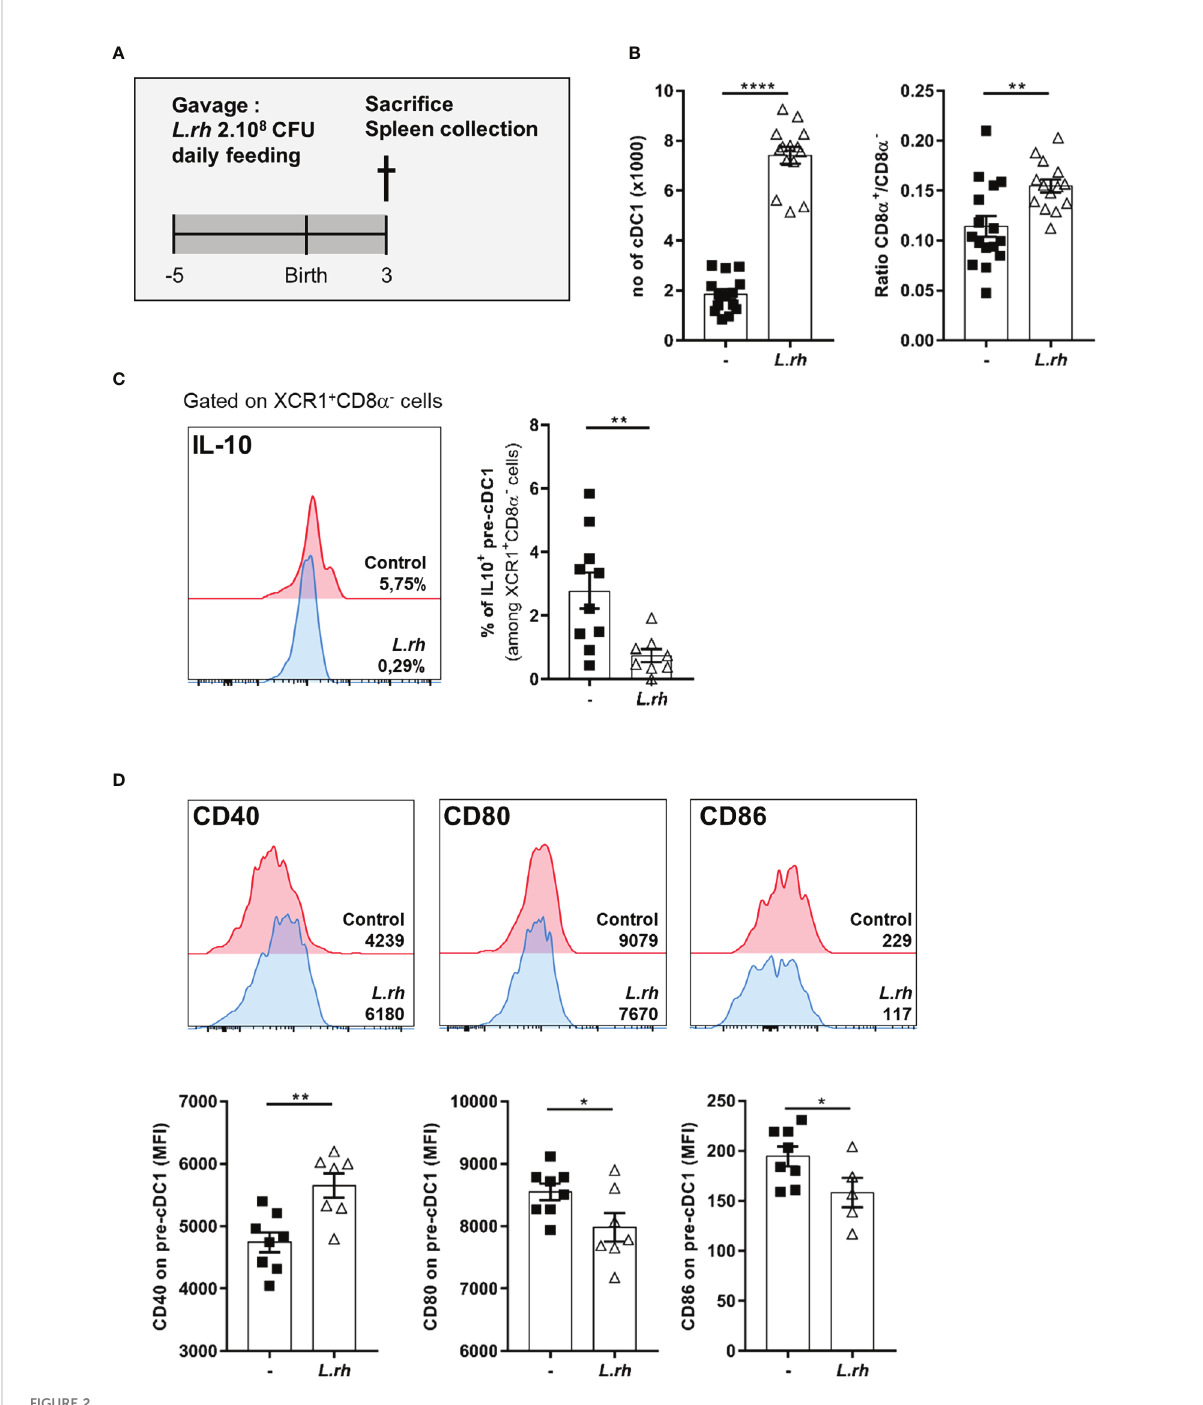
FIGURE 2 Maternal L.rhamnosus supplementation enhanced splenic pre-cDC1 differentiation and functional maturation. (A) Pregnant females were orally administered daily with 2.10 8 CFU of Lactobacillus rhamnosus VES001 from 5 days before to 3 days after delivery. The spleens of PND3 neonates born from control (-) or L.rhamnosus -treated ( L.rh ) mothers were collected and stained for FACS analysis. (B) Total number of splenic cDC1 cells, de fi ned as CD45 + F4/80 - CD64 - CD11c + MHCII + CD26 + XCR1 + SIRPa - (CD8 +/- ) cells, and CD8 a + /CD8 a - ratio among neonatal cDC1. (C) Representative single histograms and percentages of IL-10 producing pre-cDC1 were determined in the spleen of IL-10 reporter/GFP PND3 neonates. The percentages of IL-10 positive cells among pre-cDC1 of the representative samples are shown in the single histograms. (D) Representative single histograms and MFI of CD40, CD80 and CD86 co-stimulation markers in pre-cDC1 gated population. The MFI of representative samples are shown on the single histograms. Results are a pool of 2 – 3 independent experiments and are shown as mean ± SEM. Statistical analysis was done using an unpaired t test or a Mann-Whitney test. (* = p<0.05; ** = p<0.01; **** =